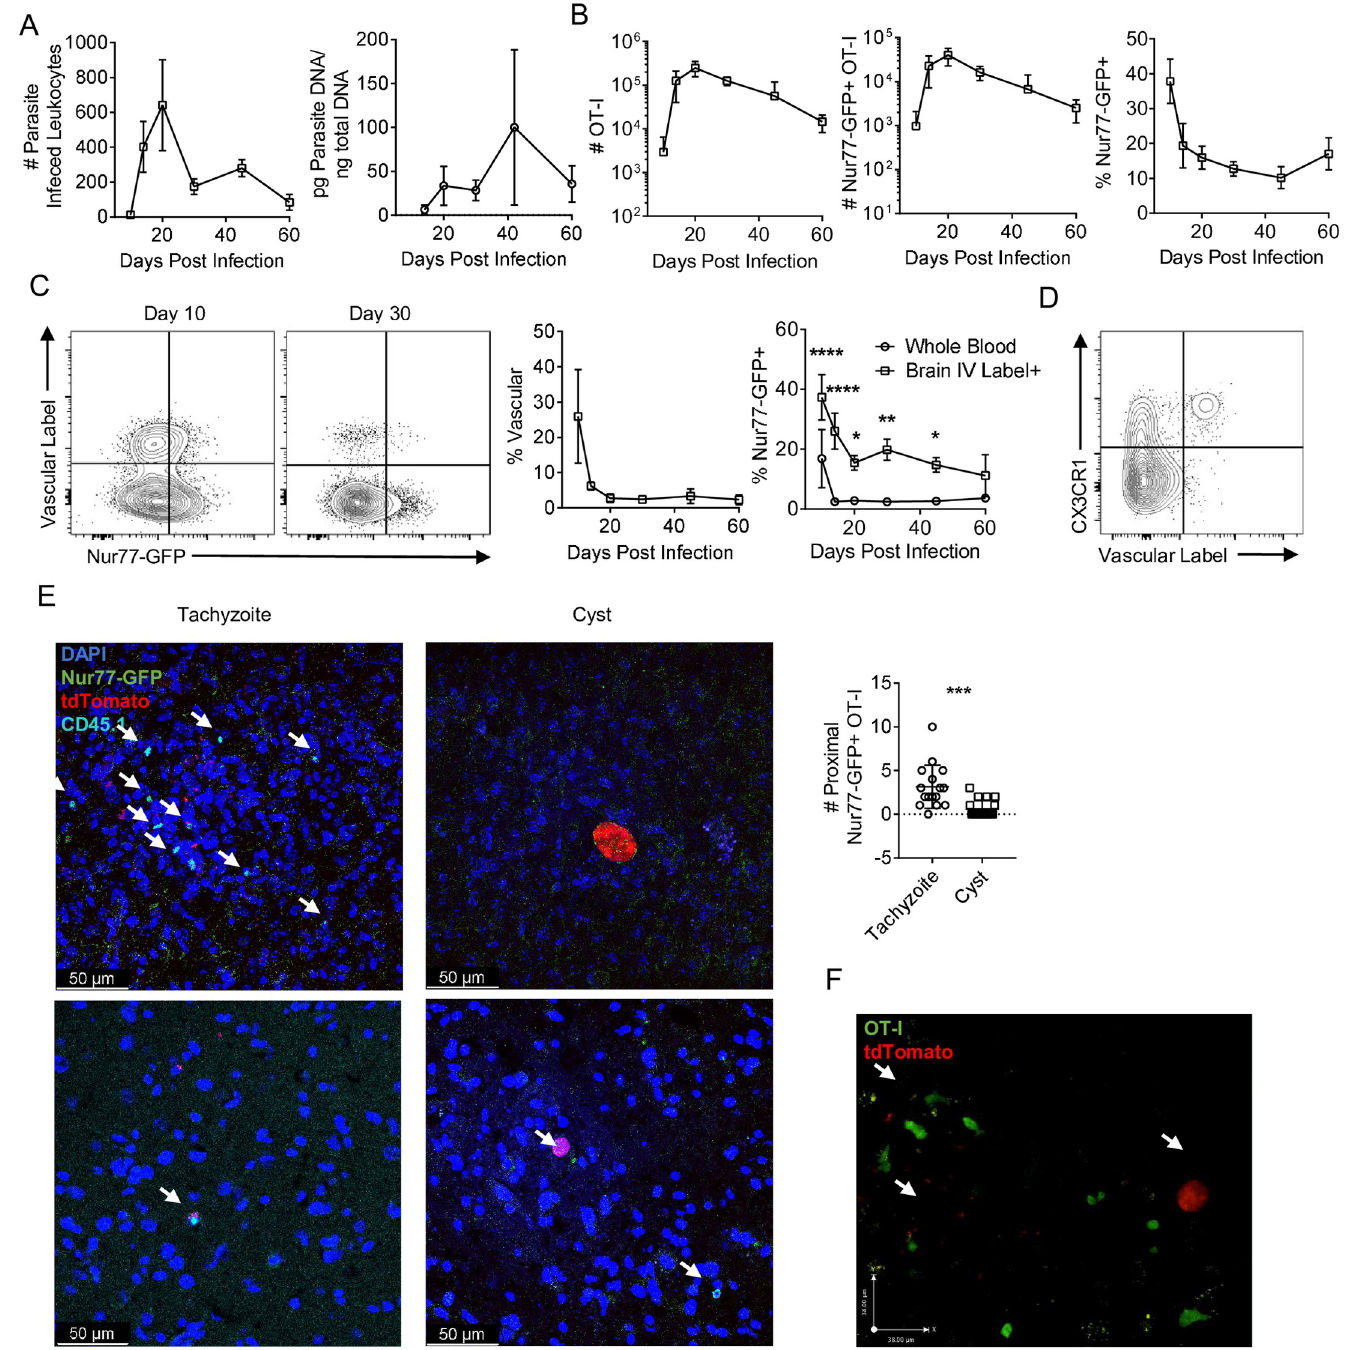
Fig 4. Infection induced kinetics of CNS T . gondii specific CD8 + T cells. (A-B) Kinetics of infection and OT-I in the brain following infection with T . gondii -OVA (N = 3–4 mice per time point). (A) Number of parasite infected leukocytes per brain as measured by flow cytometry (left) and total brain parasite burden as measured by parasite PCR (right). (B) Number of OT-I (left), number of Nur77-GFP + OT-I (center), and frequency of Nur77-GFP + OT-I of total OT-I (right) in the brain. (C-D) Mice were given i.v. dose of fluorophore conjugated α CD45 prior to sacrifice to label vascular cells. OT-I from whole blood were compared to OT-I from the vascular labeled fraction of the brain. The frequency of vascular+ OT-I in the brain was measured (left) and the frequency of Nur77-GFP + OT-I out of all OT-I in the whole blood versus the vascular + OT-I in the brain was compared (right). (N = 3–4 mice per timepoint). P values based on Two-Way ANOVA � p < 0.05 �� p < 0.01 ���� p < 0.0001; error bars indicate SD. (D) Nur77-GFP + OT-I from the CNS of T . gondii -OVA infected mice at 10 dpi. (E) Brain sections from 28 dpi were stained for CD45.1 (cyan) to identify OT-I, anti-GFP (green) to identify recently TCR stimulated OT-I, DAPI (blue) to identify nuclei, and were infected with T . gondii -OVA expressing tdTomato (red). Number of Nur77-GFP + OT-I surrounding parasites were counted. Arrows indicate Nur77-GFP + OT-I (representative of images from